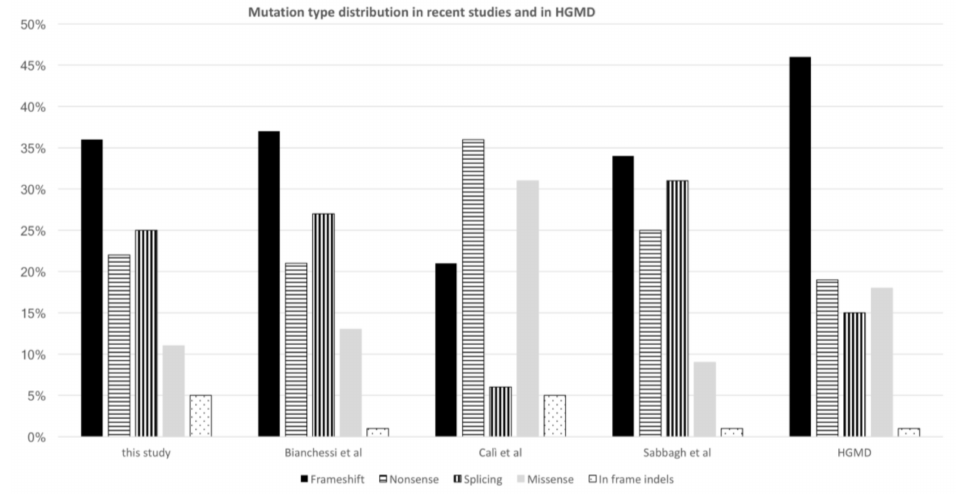
Figure 3. Comparison of mutations type distribution across recent literature and with Human Gene Mutation Database (HGMD). Bianchessi et al. [14], Cal ì et al. [13], Sabbagh et al.